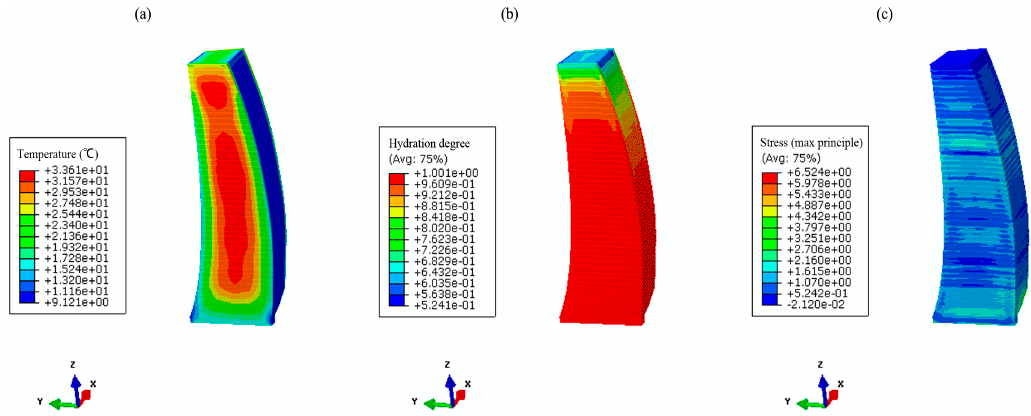
Figure 12. The coupled thermo-chemical-mechanical fields computations on 13 March 2014. ( a ) temperature (°C); ( b ) hydration degree (-); ( c ) first principle stress (MPa).